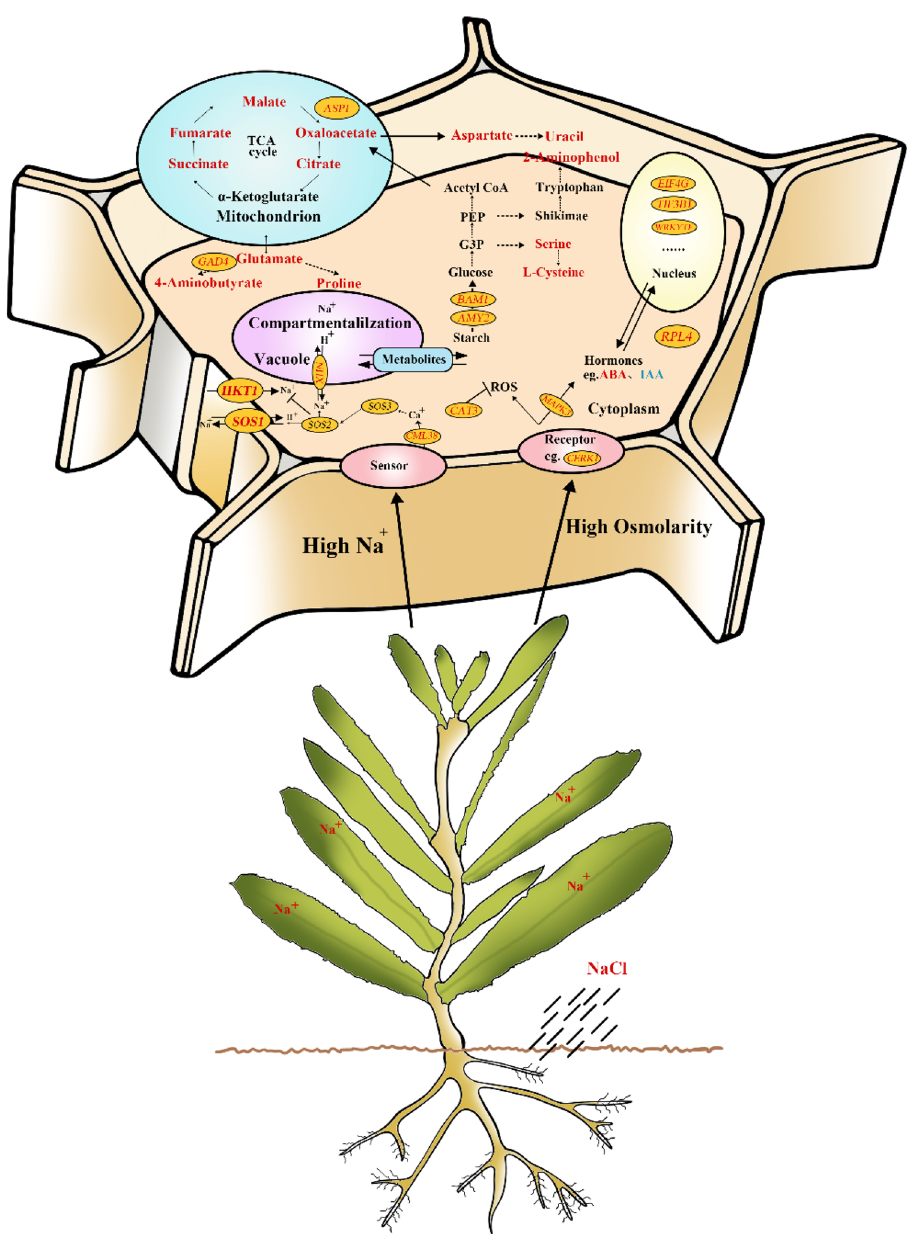
Figure 11. Diagram of the molecular and physiological metabolic pattern in response to salt stress in N.